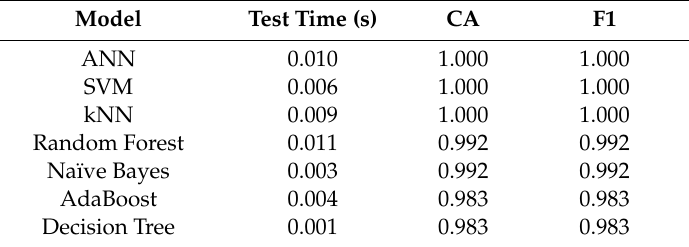
Table 5. Classifier performance, in the test dataset, using the selected best 6 input features.